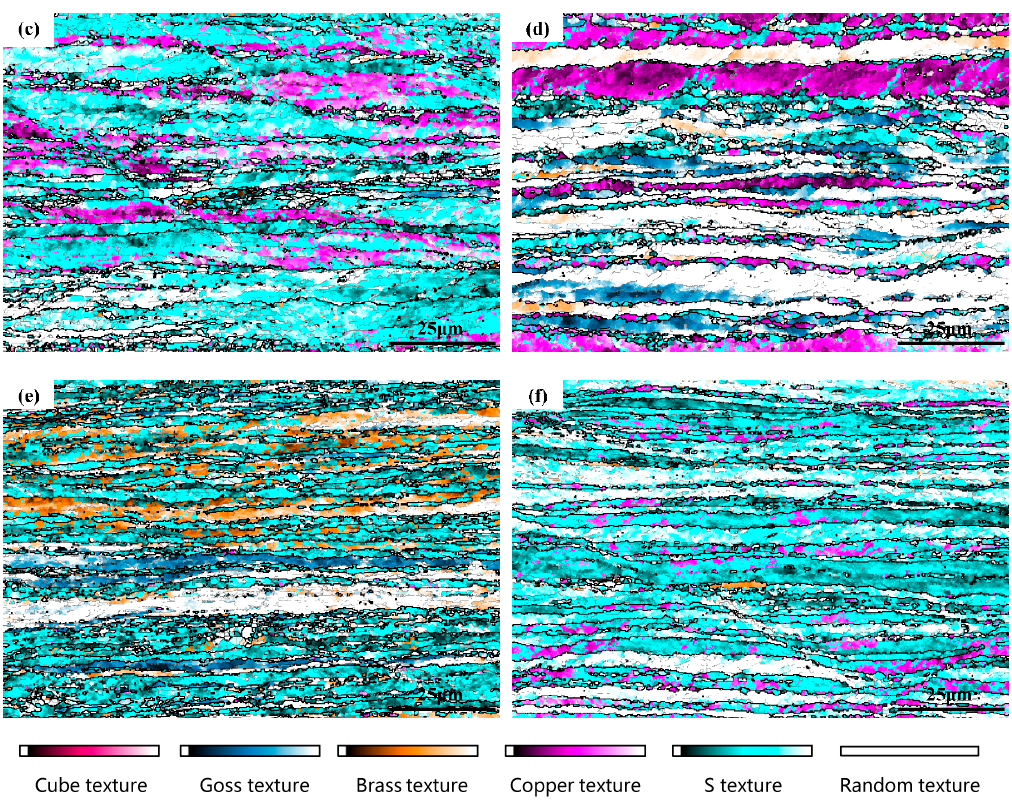
Figure 6. Orientation imaging of cold rolled alloys: ( a ) Al-3Mg-0.5Mn; ( b ) Al-3Mg-0.5Mn-0.2Er; ( c ) Al-3Mg-0.5Mn-0.2Zr; ( d ) Al-3Mg-0.5Mn-0.2Cu; ( e ) Al-3Mg-0.5Mn-0.2Si; ( f ) Al-3Mg-0.5Mn-0.2Zn.